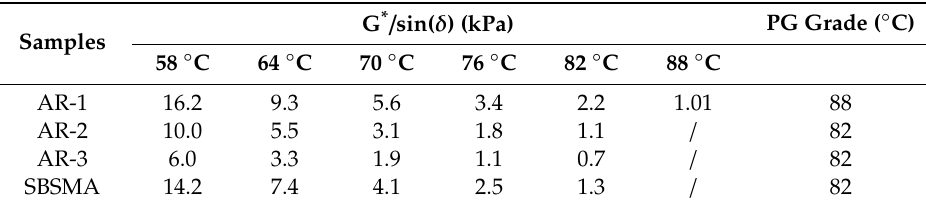
Figure 3. Results of temperature sweep. Table 6. High-temperature PG grades of AR and SBSMA